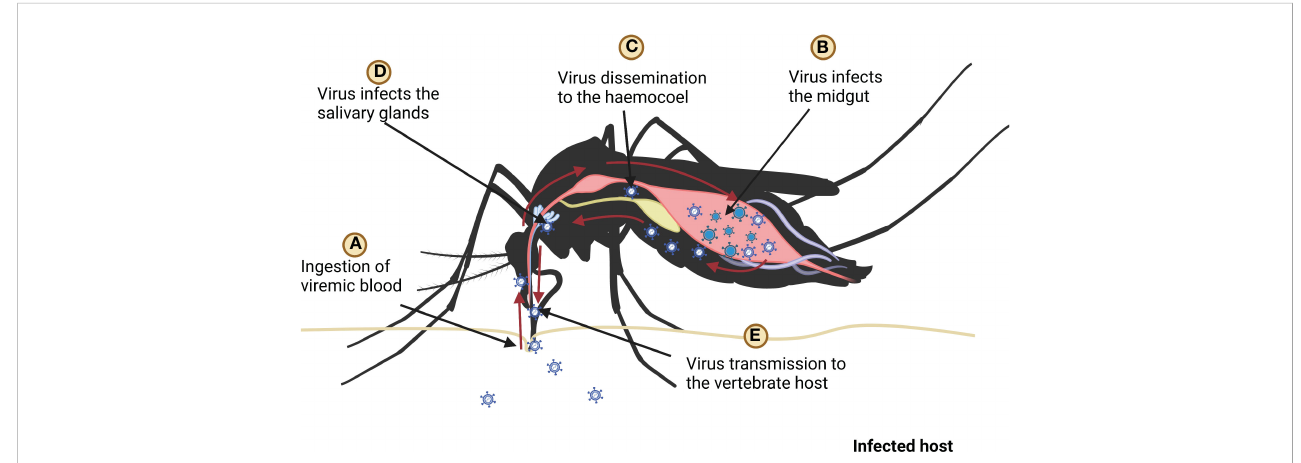
FIGURE 3 Ingestion, replication, and dissemination of virus in the mosquito, (A) mosquito ingests the blood of infected host, (B) ingested virus infects the midgut (C) after replication in the midgut virus spreads in the haemocoel, (D) after dissemination virus infects salivary glands (E) fi nally mosquito transmits virus to host by biting